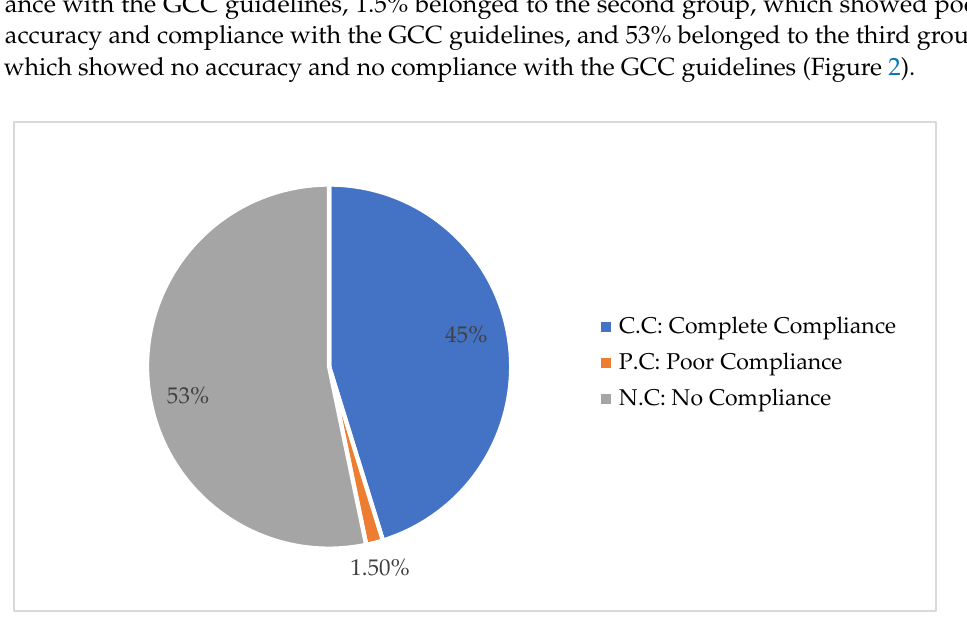
Table 1. Summary of the accuracy test results.